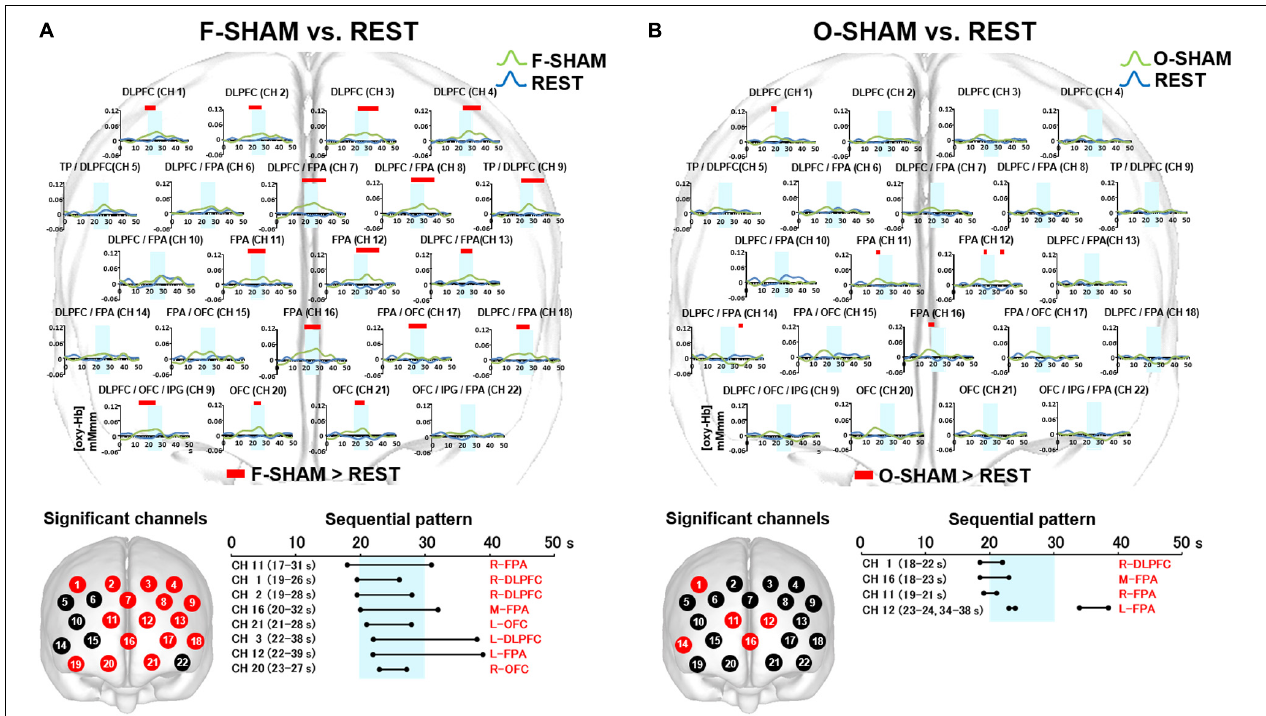
FIGURE 4 | Prefrontal functional near-infrared spectroscopy (fNIRS) activities in SHAM as compared to REST. (A) Temporal differences and sequential pattern of the prefrontal fNIRS activities in F-SHAM as compared REST. Most channels presented significant (two-way repeated measures ANOVA and Bonferroni t -test: p < 0.05) prefrontal activation in F-SHAM as compared to REST. A sequential pattern of significant (two-way repeated measures ANOVA and Bonferroni t -test: p < 0.05) prefrontal activations presented temporally overlapped features with regard to the onset and duration of the DLPFC/FPA/OFC activities between F-SHAM and REST. (B) Temporal differences and sequential pattern of the prefrontal fNIRS activities in O-SHAM as compared to REST. Several channels presented significant (two-way repeated measures ANOVA and Bonferroni t -test: p < 0.05) prefrontal activations in the DLPFC and FPA in O-SHAM as compared to